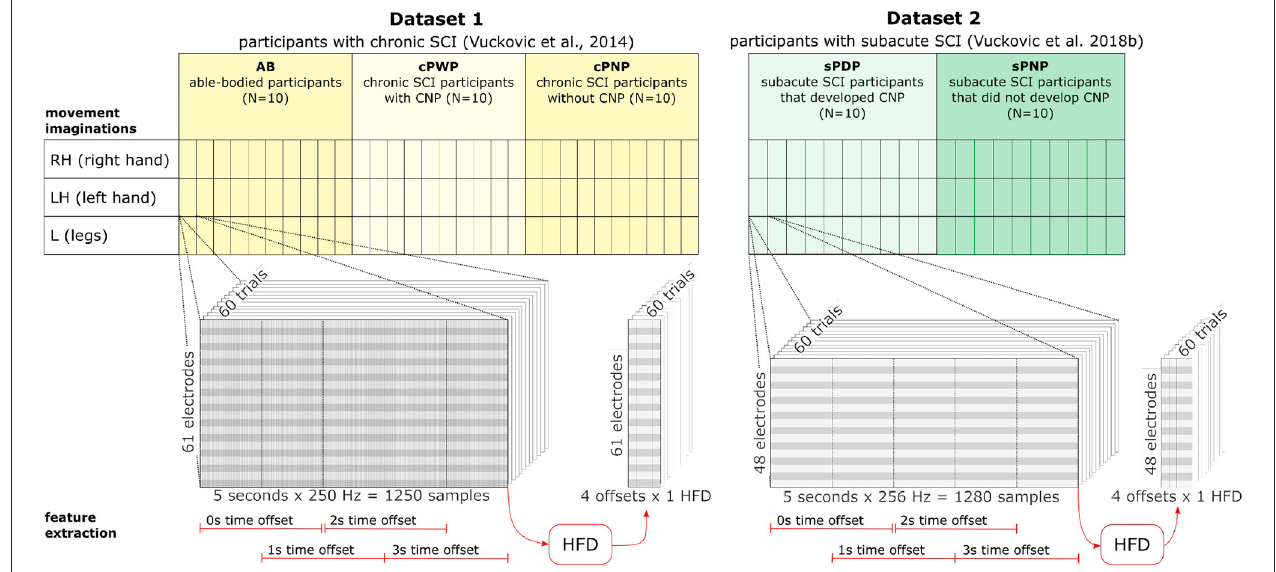
FIGURE 2 | Dataset organisation (top) and feature extraction (bottom) . Dataset 1 includes data from three groups (AB, cPWP, cPNP) with 10 participants in each group. Each participant’s MI of three different movements (RH, LH, L) were recorded with 60 repetitions per movement conducted in semi-random order. Each recording contains 5 s data sampled at 250 Hz at 61 electrode positions. Dataset 2 includes data from two groups (sPDP, sPNP) with 10 participants in each group. Each participant followed the same experimental protocol as in Dataset 1. Each recording contains 5 s data sampled at 256 Hz at 48 electrode positions. See section 2.1 for more detail. HFD features were extracted at each electrode position from four temporal windows of 2 s length, each offset by 50%. See section 2.2 for more detail.